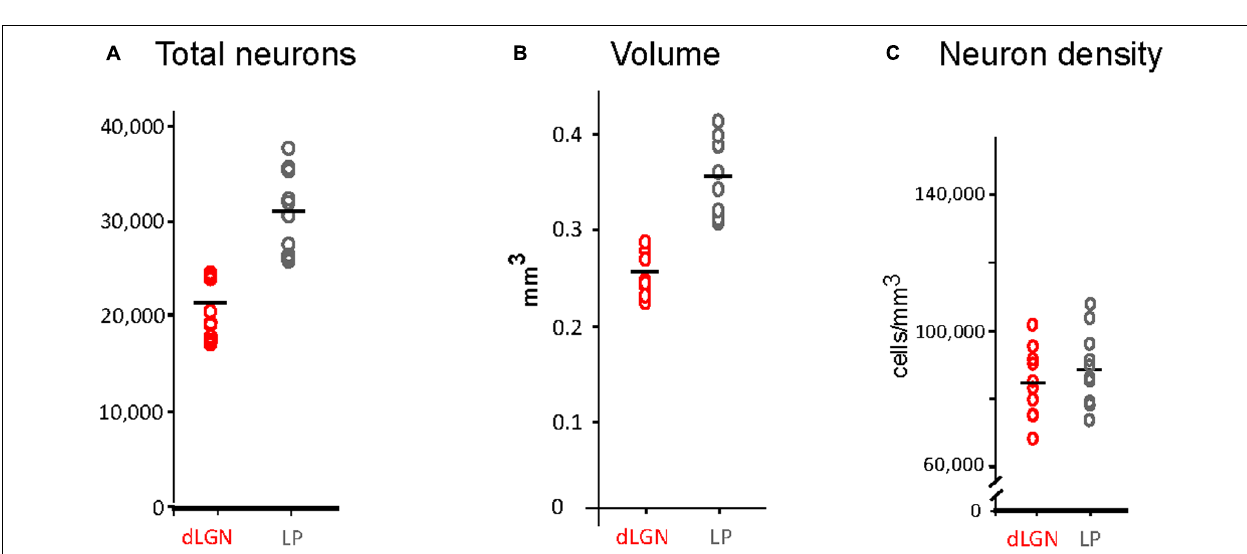
FIGURE 3 | High-magnification samples of VGluT2 neuropil labeling in different thalamic visual nuclei. (A) Sample from dLGN. (B) Sample from LPL. (C) Sample from LPMC (D) Sample from LPMR. Note that the vGluT2 corpuscles (putative neurotransmitter vesicle pools in axon terminals) are larger and more abundant in LPMC and dLGN. Samples were taken from the regions pointed with a yellow asterisk in Figure 2 . Scale bar = 25 µ m.